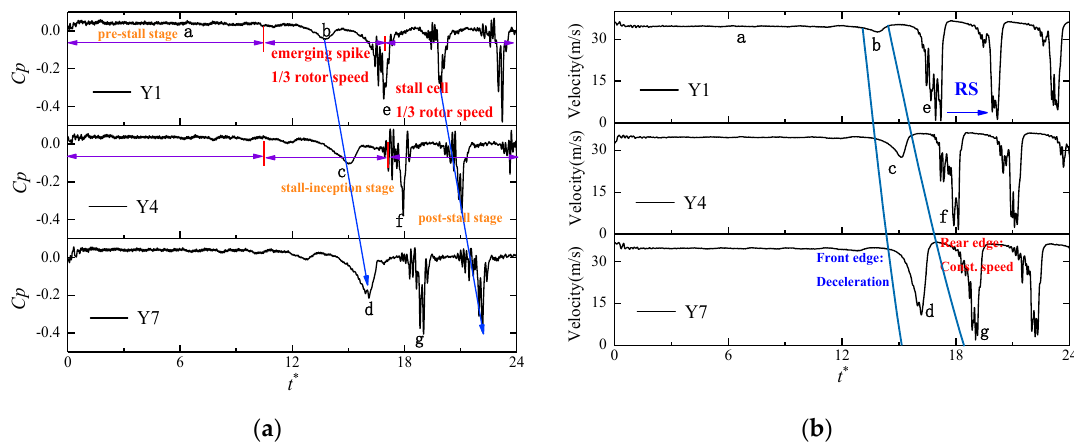
Figure 14. Transient pulsation process of signal under hump point. ( a ) Transient pressure fluctuation process; ( b ) Transient velocity fluctuation process.